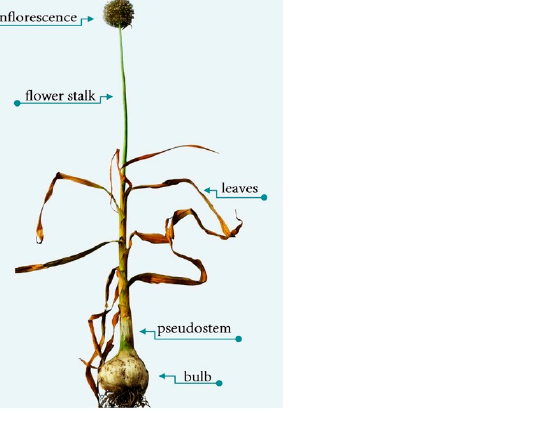
Figure 2. Morphological description of the Allium plant (photo by S. Vukovi ć ).